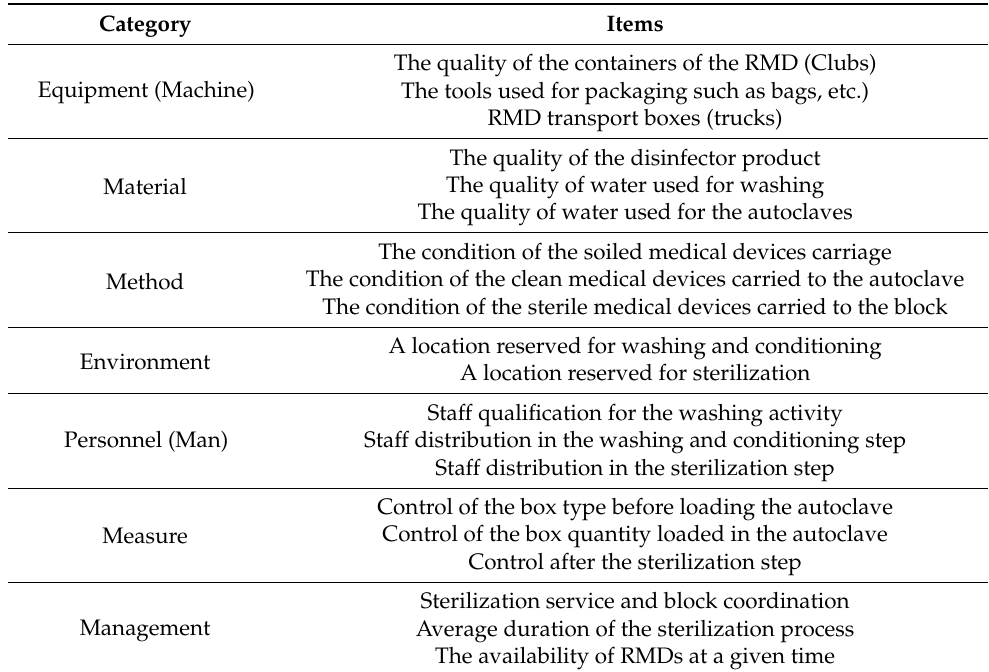
Table 5. Possible design requirements and improvement